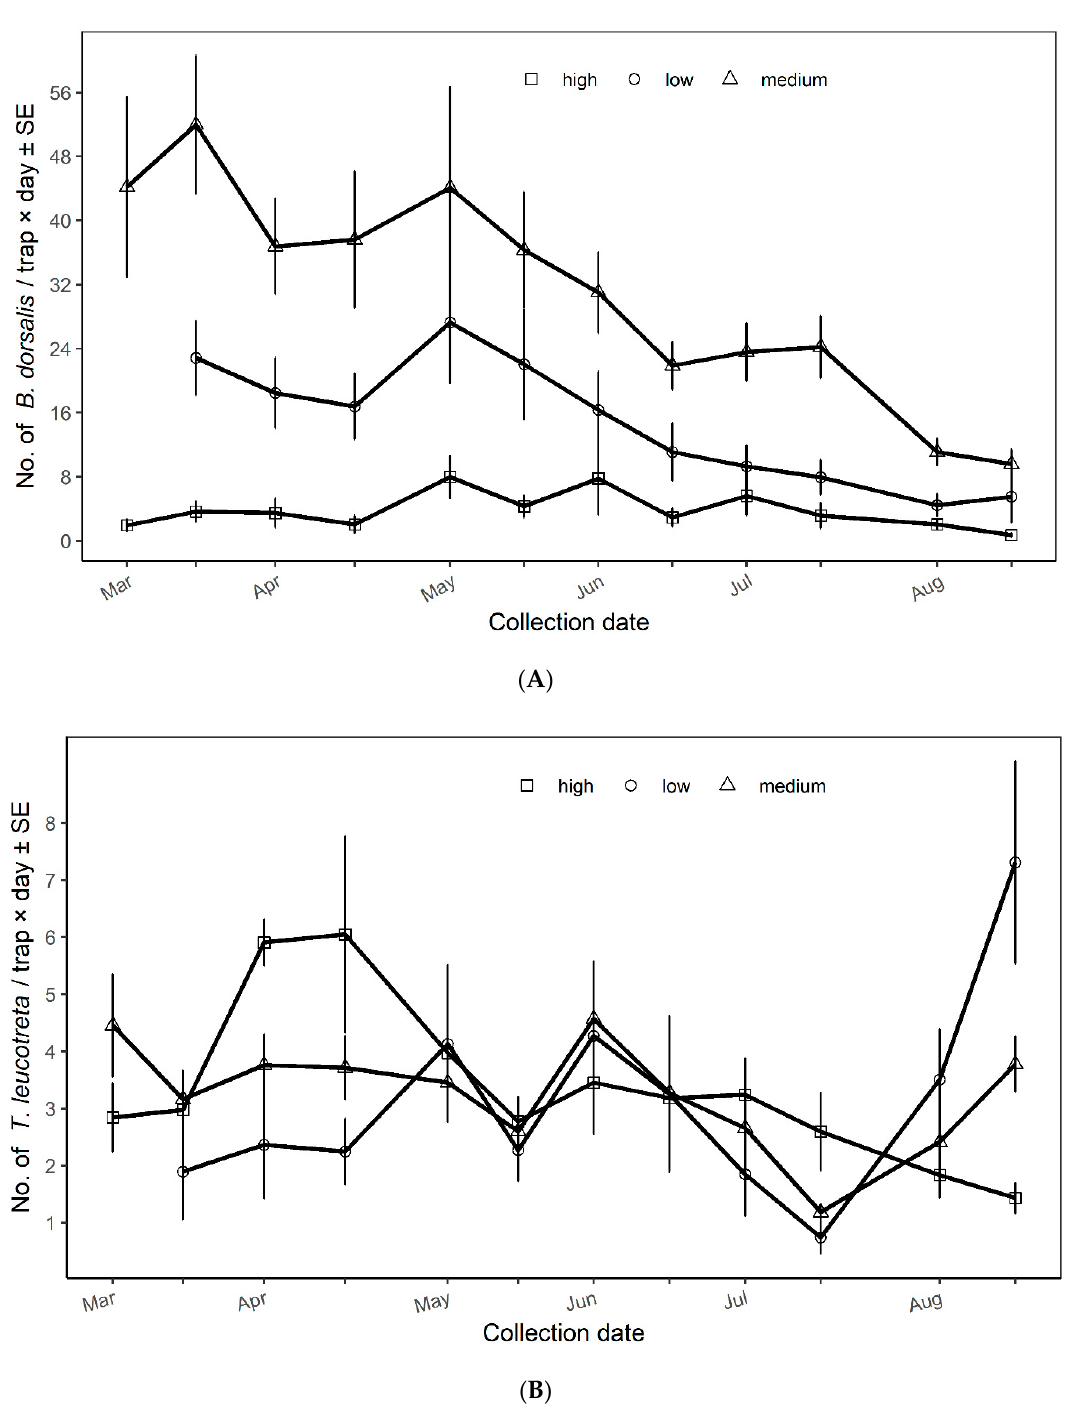
Figure 3. Population dynamics of ( A ) the oriental fruit fly Bactrocera dorsalis and ( B ) the false codling moth Thaumatotibia leucotreta in small avocado farms across vegetation productivity classes. The best-fitted model which explained B. dorsalis variation between vegetation productivity classes had both farm and collection time as random effects (AIC = 3584.50). Analysis indicated that the farm ( χ 2 = 153.25; df = 1,5; P < 0.0001) and collection time ( χ 2 = 63.93; df = 1,5; P < 0.0001) influence the variance of B. dorsalis catches. Landscape vegetation productivity significantly influenced B. dorsalis catches (F = 12.85; df = 2,37; P < 0.0001), being higher in medium vegetation productivity class, followed by low and high classes (Table 1).